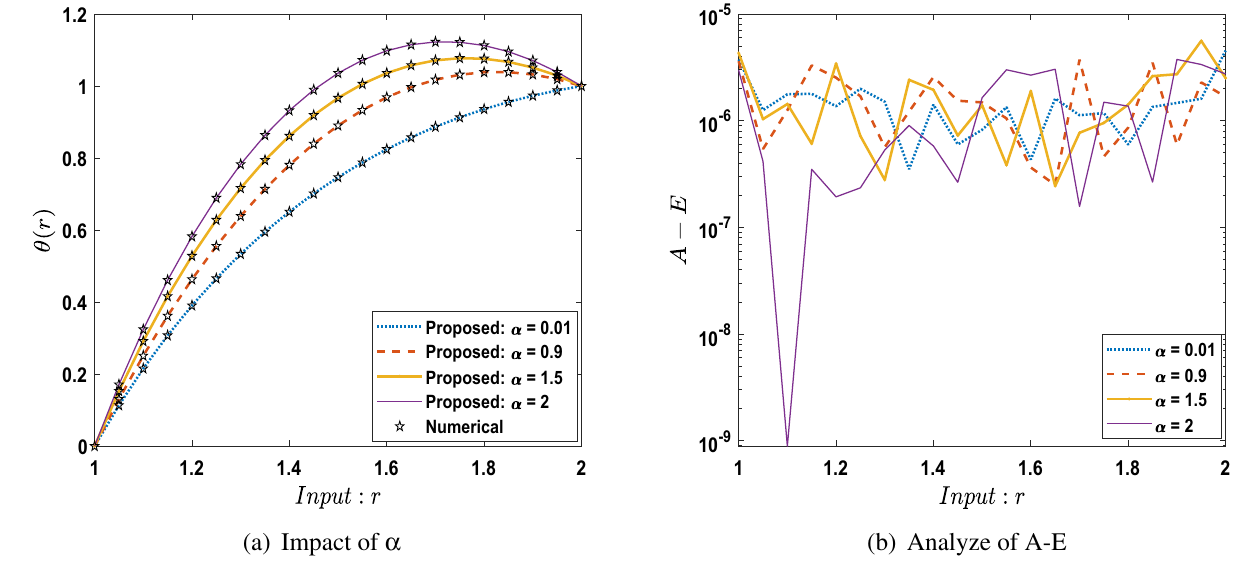
Figure 24. Comparison between LMA-TNN with results of numerical reference for scenario 4 in constant viscosity.